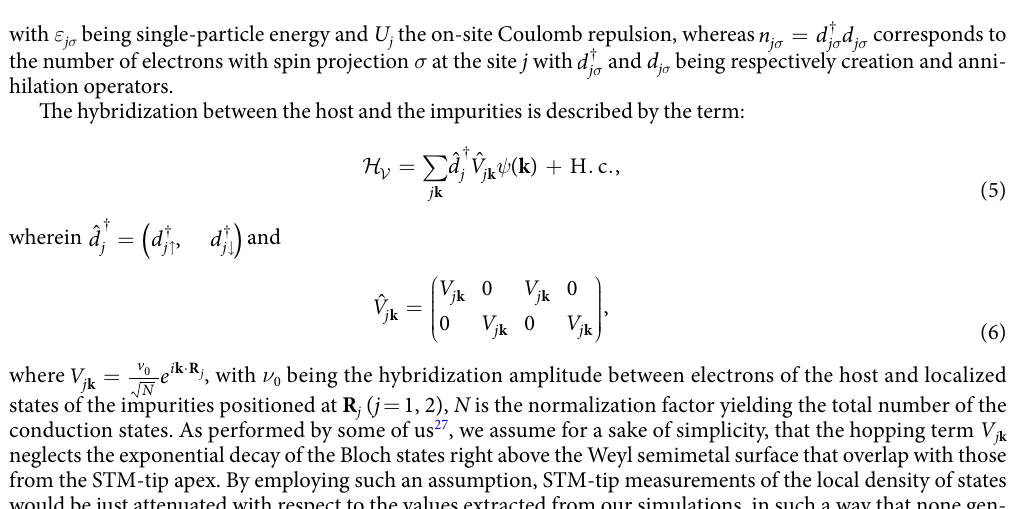
† n σ σ corresponds to